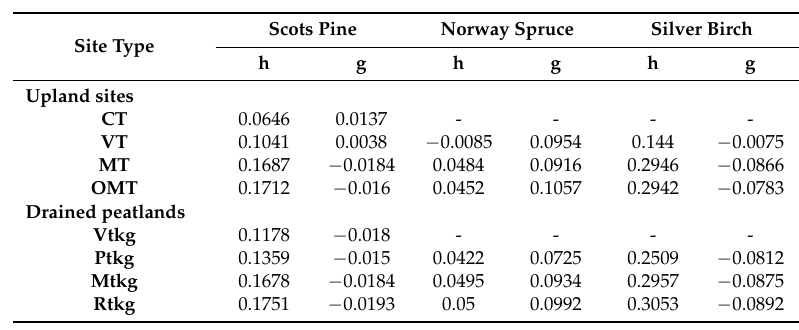
Table A1. Parameters used in Equation (5) on upland sites (mineral soils) and drained peatland sites with comparable fertility. Legends: The upland site types included poor (dry heath, Calluna type, CT), quite poor (dryish heath, Vaccinium type, VT), medium (fresh heath, Myrtillus type, MT), and rich (grove-like heath, Oxalis-Myrtillus type, OMaT) sites. Vtkg, Ptkg, Mtkg, and Rtkg are drained peatland sites with fertility comparable to that of CT, VT, MT, and OMT upland sites.